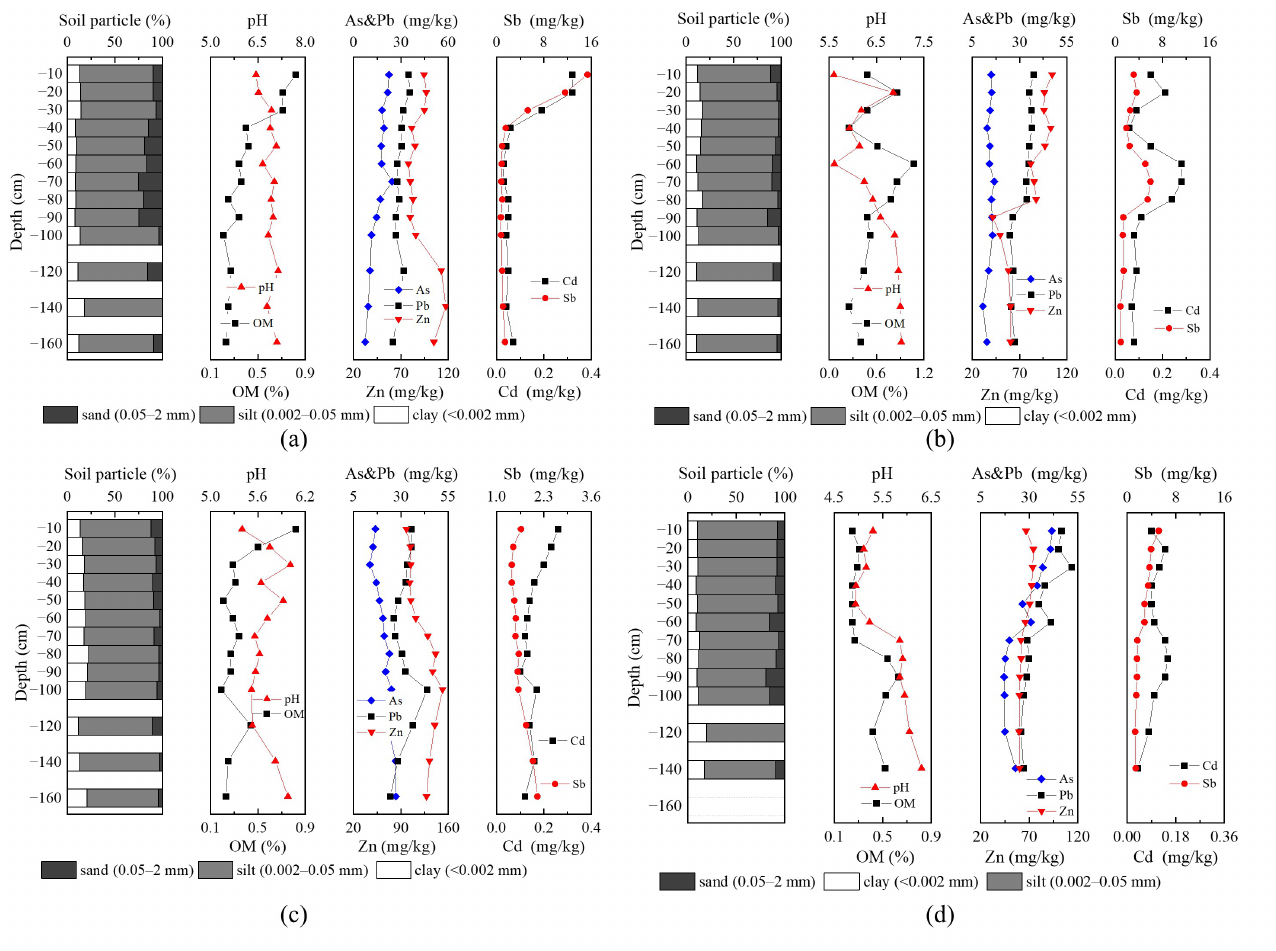
Figure 4. Distribution of heavy metals and metalloids in typical soil profiles: The first column is the vertical distribution of soil particles, the second column is the vertical distribution of pH and organic matter, the third column is the vertical distribution of As, Pb, and Zn, and the fourth column is the vertical distribution of Cd and Sb. ( a ) XBP01, located downstream of Zishui. ( b ) XB-P02, located in the middle and lower reaches of Zishui. ( c ) LX-P01, located in the middle and upper reaches of Zishui. ( d ) LX-P02, located upstream of